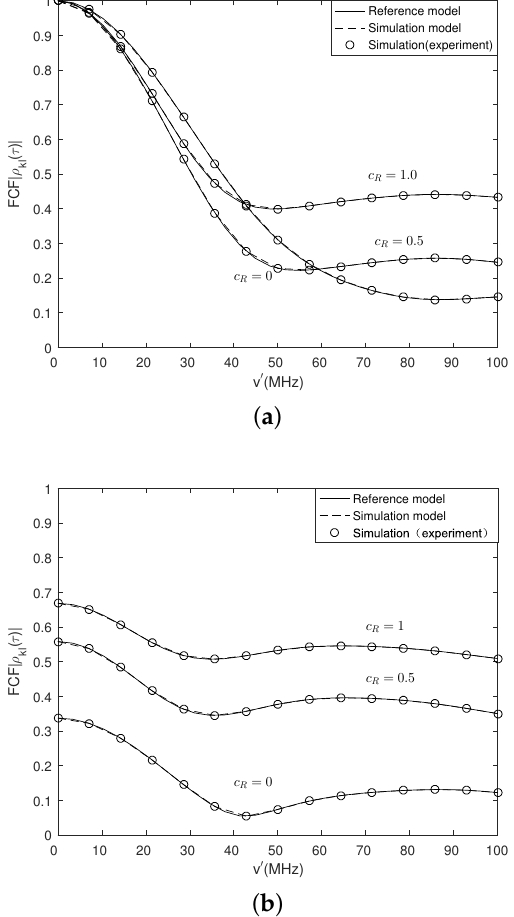
Figure 8. FCF of SET and without ceiling for different Rice factors c R . ( a ) FCF of SET. ( b ) FCF of SET without